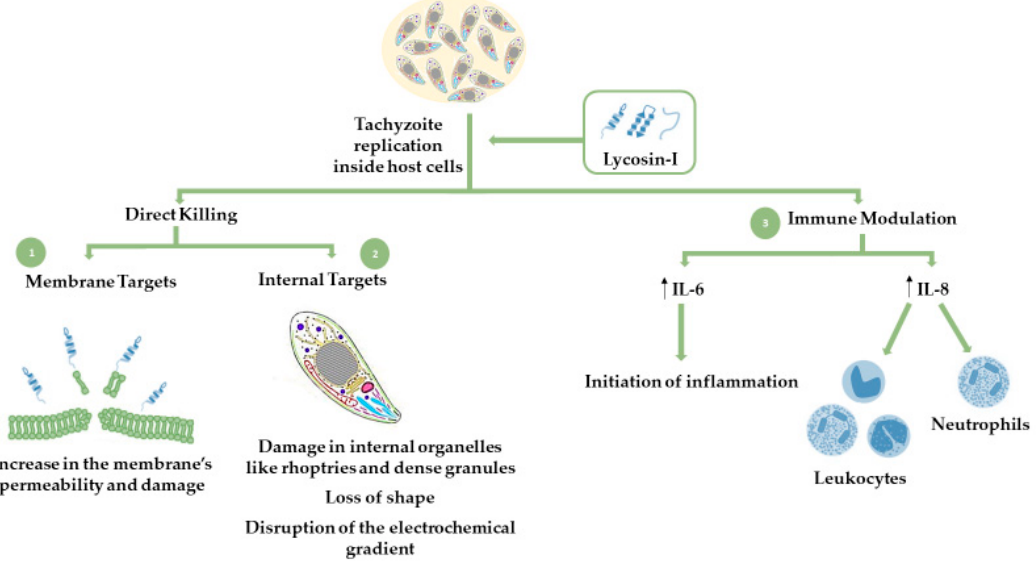
Scheme 1. Schematic representation of the mechanism proposed for the action of antimicrobial peptide (AMP) lycosin-I on T. gondii -i nfected host